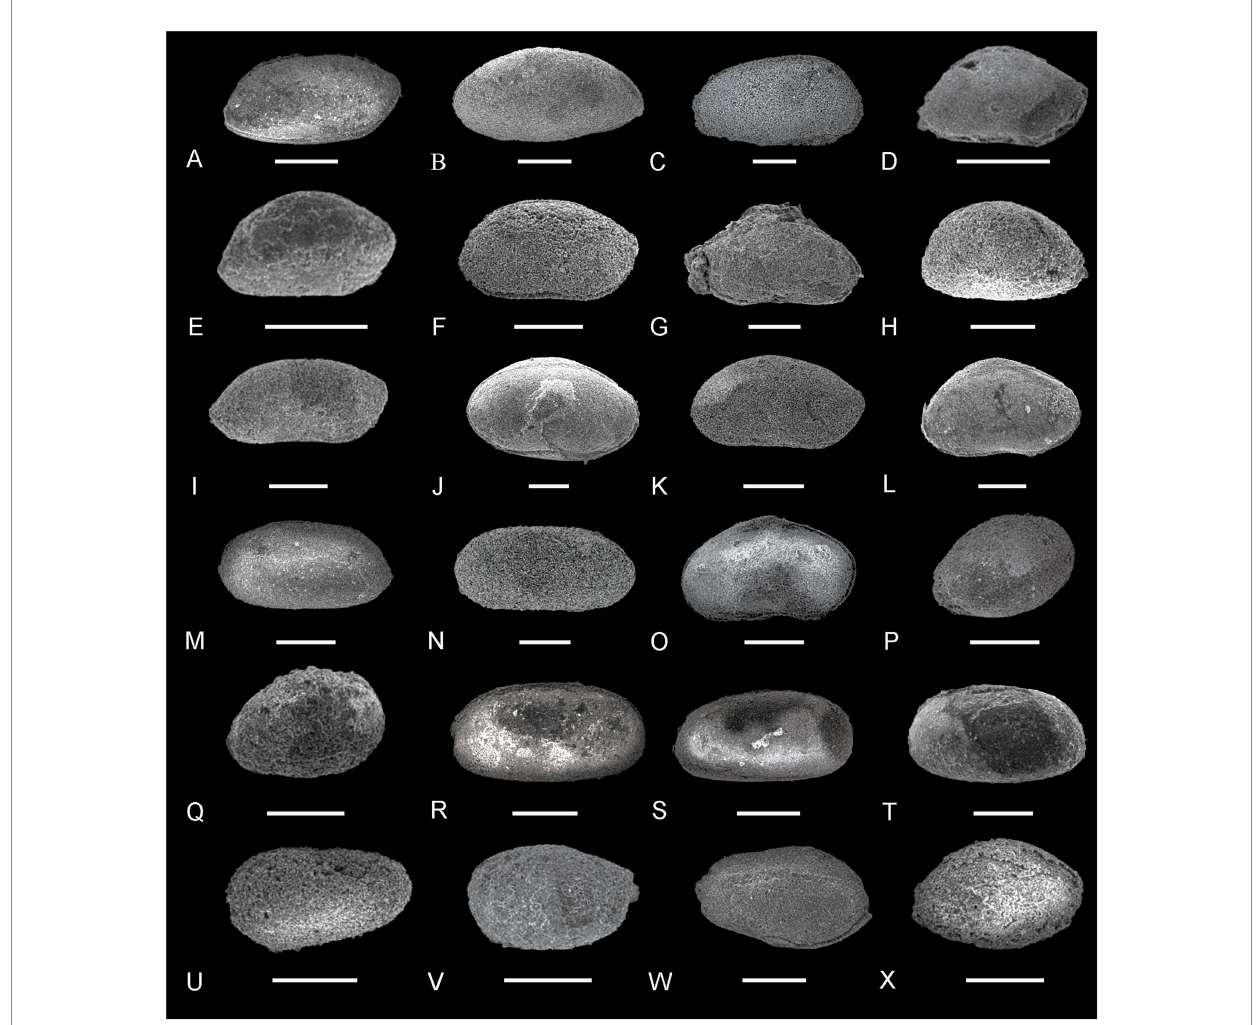
FIGURE 3 Ostracods from the Youping Section (I). (A) Acratia cf. subfusiformis Wang, right lateral view, sample YP-18; (B) , Acratia sp., left lateral view, sample YP-3; (C) , Aqoviella sp., right lateral view, sample YP-9; (D) Bairdia beedei Ulrich and Bassler, right lateral view, sample YP-7; (E,F) Bairdia cahuzaci Forel, right lateral view, sample YP-7 and YP-8; (G) Bairdia davehornei Forel, right lateral view, sample YP-7; (H) Bairdia jermei Forel, left lateral view, sample YP-5; (I) Bairdia kemerensis Crasquin-Soleau, right lateral view, sample YP-15; (J) Bairdia subsymmetrica Shi, left lateral view, sample YP-4; (K) Bairdia wailiensis Crasquin-Soleau, right lateral view, sample YP-8; (L) Bairdiacratia sp., right lateral view, sample YP-5; (M,N) Bairdiacypris changxingensis Shi, right lateral view, sample YP-18; (O) Bairdiacypris fornicata Shi, right lateral view, sample YP-5; (P,Q) Basslerella superarella Crasquin, right lateral view, sample YP-18; (R,S) Callicythere lysi Crasquin-Soleau, right lateral view, sample YP-18; (T) Callicythere mazurensis Styk, left lateral view, sample YP-18; (U) Callicythere postiangusta Wei, left lateral view, sample YP-8; (V,W) Cavellina nesenensis Crasquin, V : left lateral view; W : right lateral view, sample YP-18; (X) Citrella ampelssbachensis Kozur and Bolz, right lateral view, sample YP-17. Scale bars = 200 μ